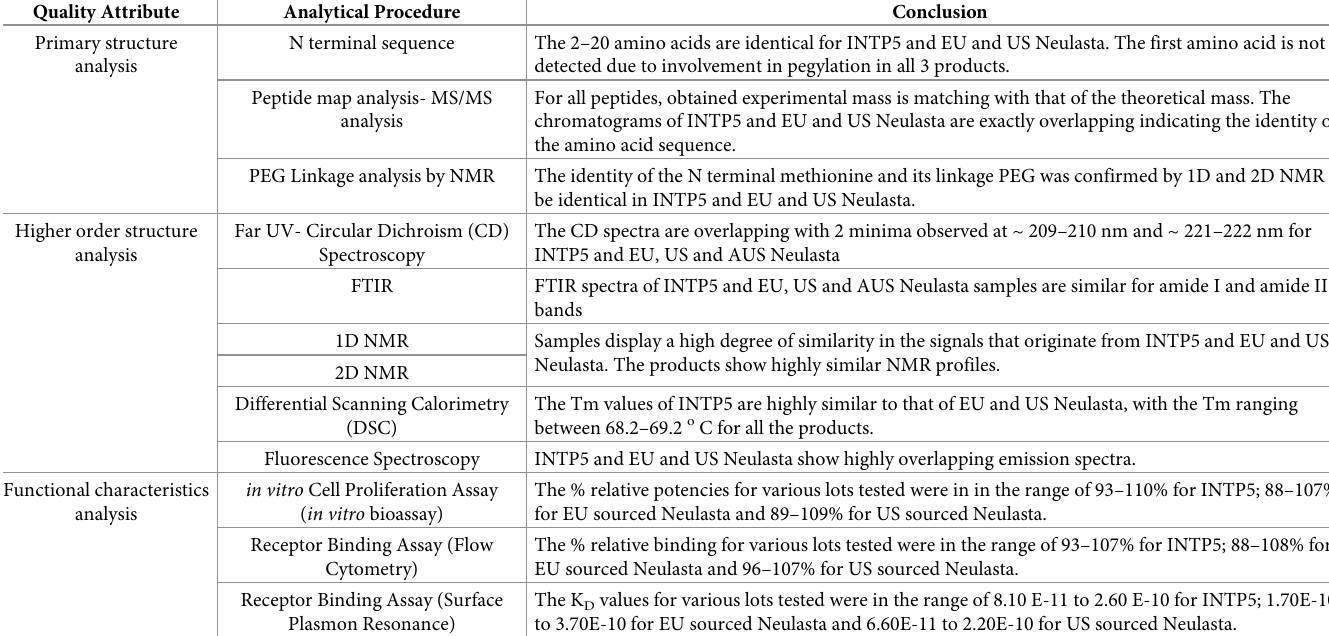
Table 1. List of methods used for assessment of primary structure, higher order structure and functional characteristics of INTP5, EU sourced Neulasta and US sourced Neulasta. Quality Attribute